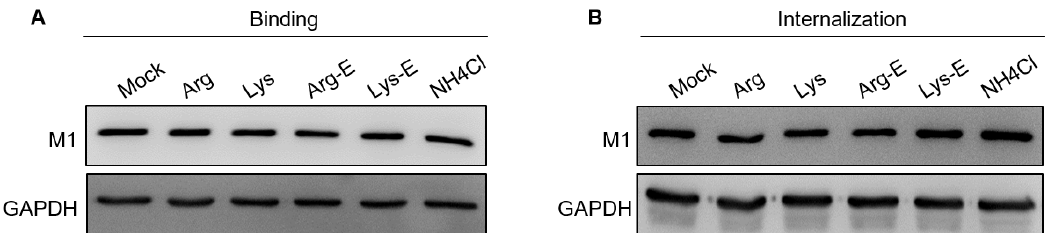
Figure 5. Compound effects on IAV binding and internalization. A549 cells were treated with the compounds for 1 h, then infected with IAV (MOI 5) at 4 °C for 1 h in the presence of the compounds. ( A ) After virus infection, the cells were washed with cold PBS to remove the unbound virus and then harvested. ( B ) Following virus infection, the cells were refreshed with a warm medium and incubated at 37 °C for an additional 1 h with the compounds. Cell lysates were harvested and analyzed by Western blotting with anti–M1 antibody. The concentrations of the compounds were 10 nM, except for NH 4 Cl, 20 mM. Mock: medium only.